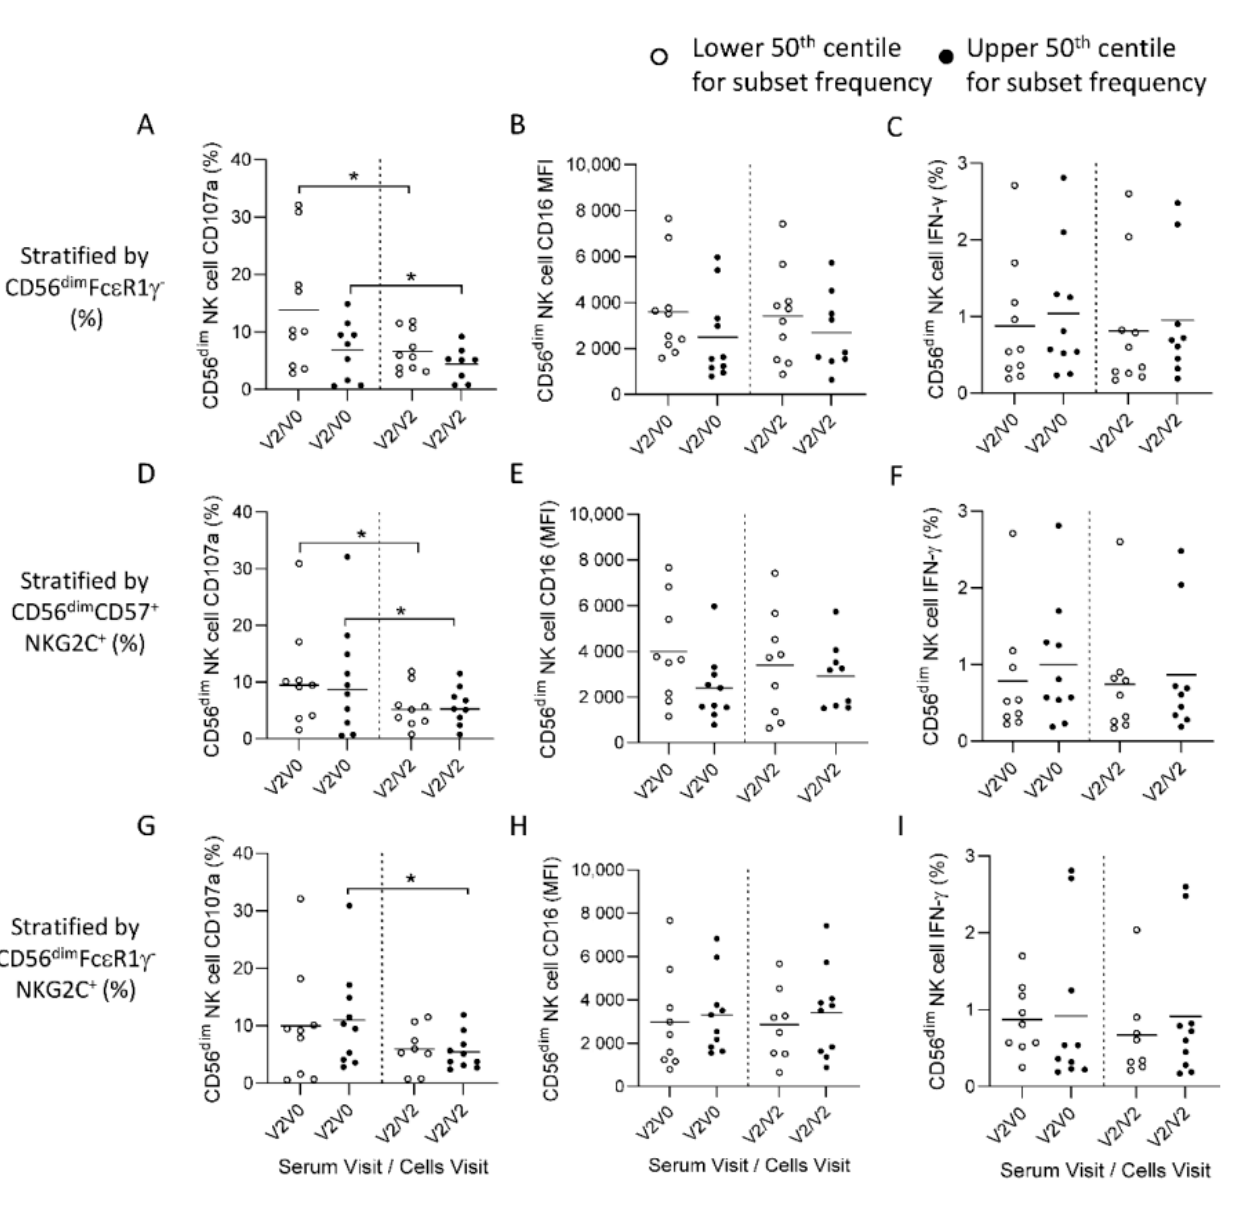
Figure 4. HCMV-associated adaptive expansions and ADNKA responses. Comparison of ADNKA cell CD107a ( A , D , G ), CD16 mean fluorescence intensity (MFI) ( B , E , H ) and IFN- γ ( C , F , I ) expression in groups defined according to HCMV associated NK cell expansions. Responses to autologous post vaccination serum (21 days post-dose two; Visit two) combined with either baseline (V0) or post-dose two (V2) cells were assessed ( A – C ). Responses were compared between lower ( n = 9, open circles) and upper ( n = 9, filled circles) 50th centiles for frequencies of CD56 diim Fc ε R1 γ − ( A – C ); CD56 dim CD57 + NKG2C + ; ( D – F ) or CD56 dim Fc ε R1 γ − NKG2C + subsets; G – I ) as determined in Figure 1. Data points are shown with a line representing median values. Comparisons across visits were performed using a one-way ANOVA mixed effects analysis with a Geisser-Greenhouse correction. * p < 0.05.